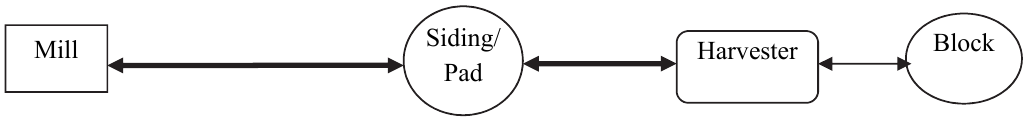
Fig. 5. Factory Road/Infield transport systems